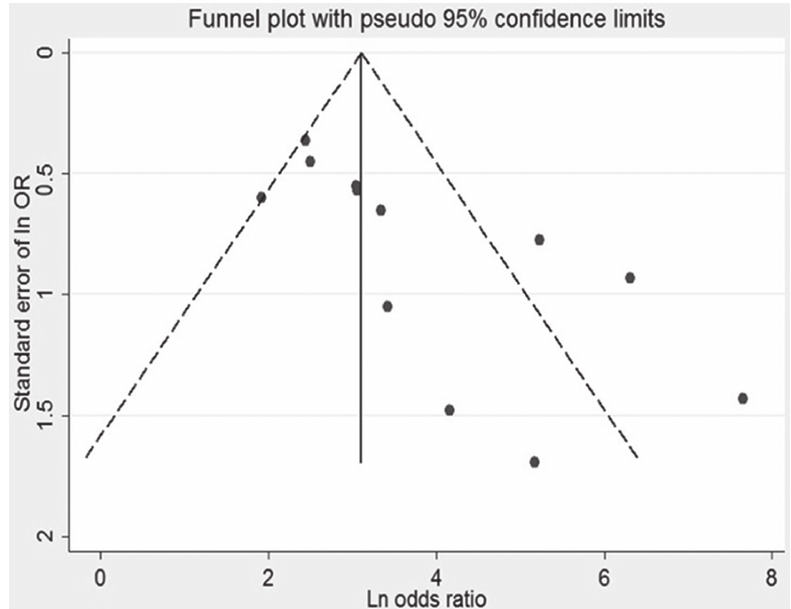
Figure 5 - Funnel plot of estimated publication bias.